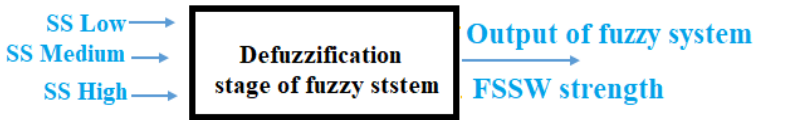
Figure 12. Outputs of FSSW strength fuzzy system. Table 7. Membership functions of FSSW strength fuzzy system outputs. Fuzzy System Output Variable